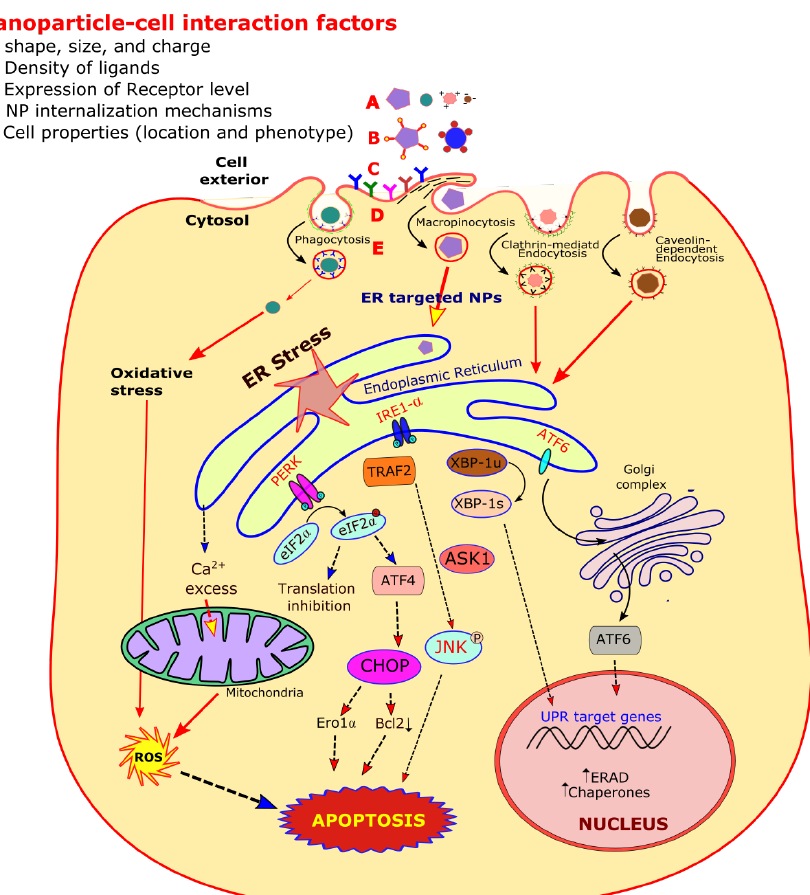
Figure 1. A diagrammatic representation of endoplasmic reticulum (ER) stress and oxidative stress facilitated signaling pathways induced by different types of nanoparticles (NPs). The